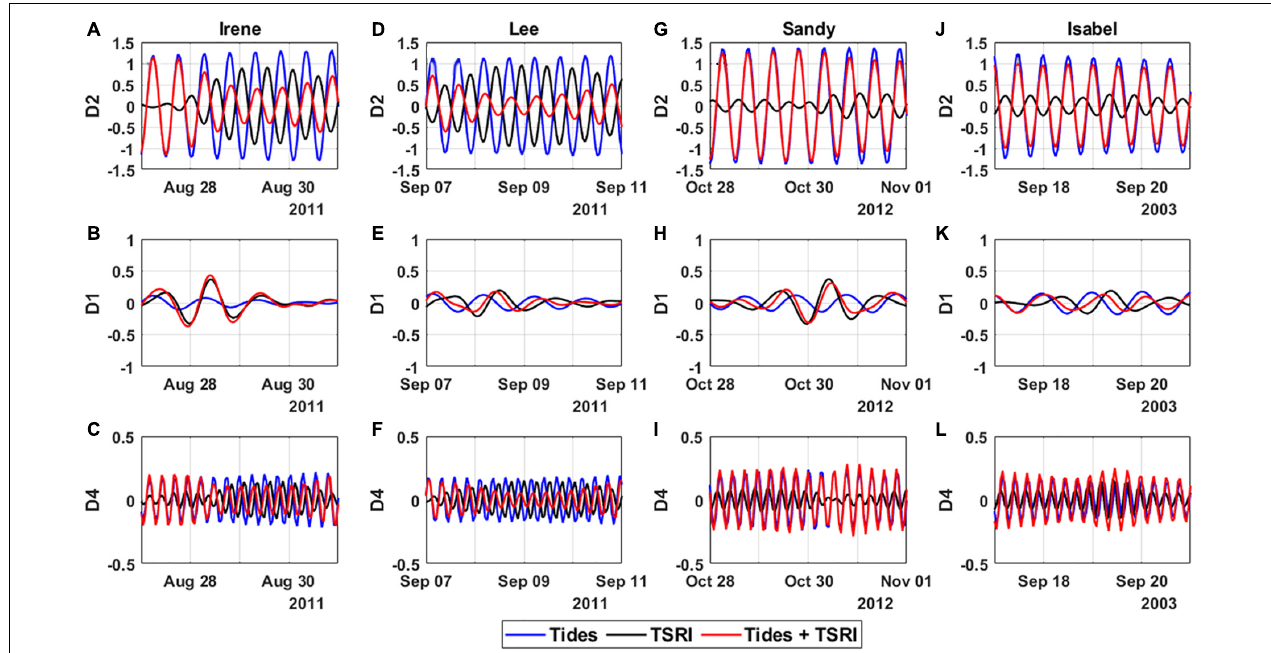
FIGURE 9 | Time series of predicted tides (blue), TSRI (black), and tides plus TSRI (red) for the D2, D1, and D4 bands (top to bottom) during Irene (A–C) , Lee (D–F) , Sandy (G–I) , and Isabel (J–L) at the NB station.